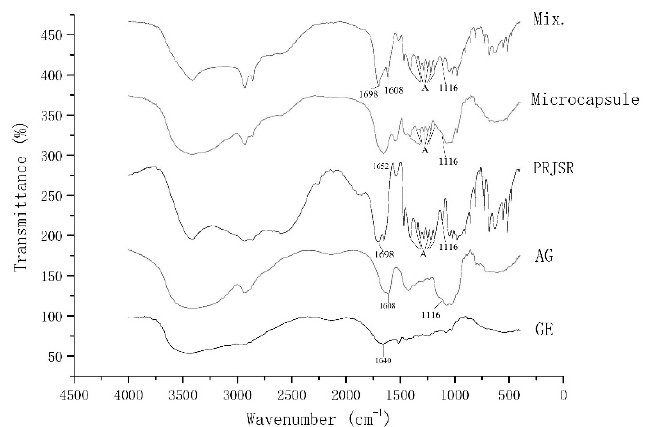
Figure 4. FTIR spectra of the microcapsules and their materials.